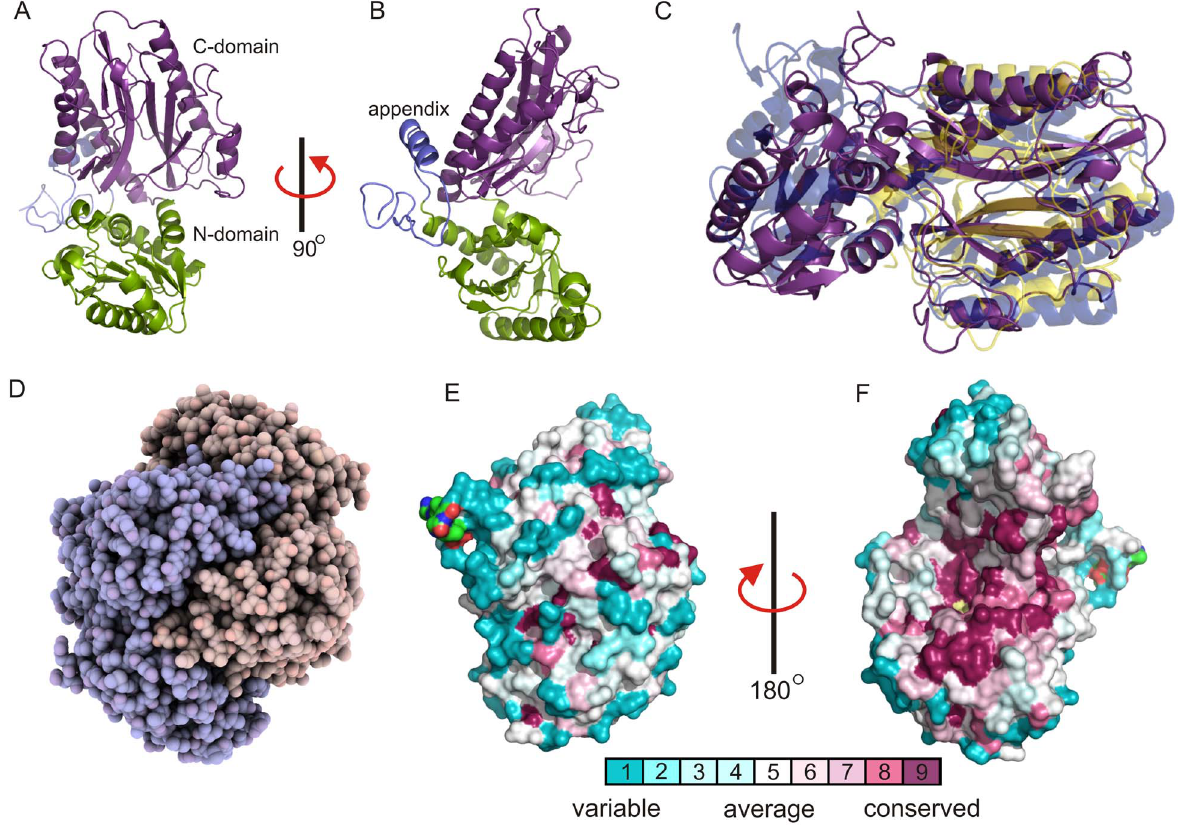
Figure 3. Rd DddP has a two-domain structure with the pita bread domain of metallopetidases. ( a ) Frontal view of the pita bread C- domain (purple), the N-terminal domain (green) and the appendix (blue). ( b ) Side view of the enzyme. ( c ): Structural alignment of Rd DddP (purple) with the creatinase 1CHM (transparent blue) and the methionine aminopeptidase 1 MAT (transparent yellow). ( d ) Homodimer of Rd DddP shown as a sphere model with the two chains in beige and blue. ( e ), ( f ) Surface representations of the monomer with a color code, calculated from multiple DddP lyases revealing that the dimer interface is highly conserved. ( e ) View of the solvent exposed part of the monomer shows little conservation. ( f ) View of the buried dimer interface area shows high conservation. The conservation scores were calculated with the Consurf server using default settings. Structure figures were prepared with Pymol and QuteMol.